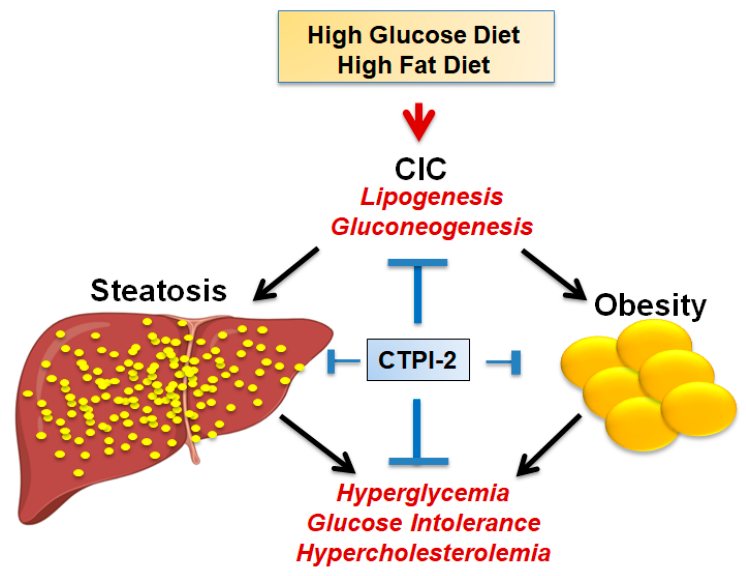
Figure 5. Schematic representation of some of the salient effects of CTPI-2 in the non-alcoholic fatty liver disease/non-alcoholic steatohepatitis (NAFLD/NASH) model.